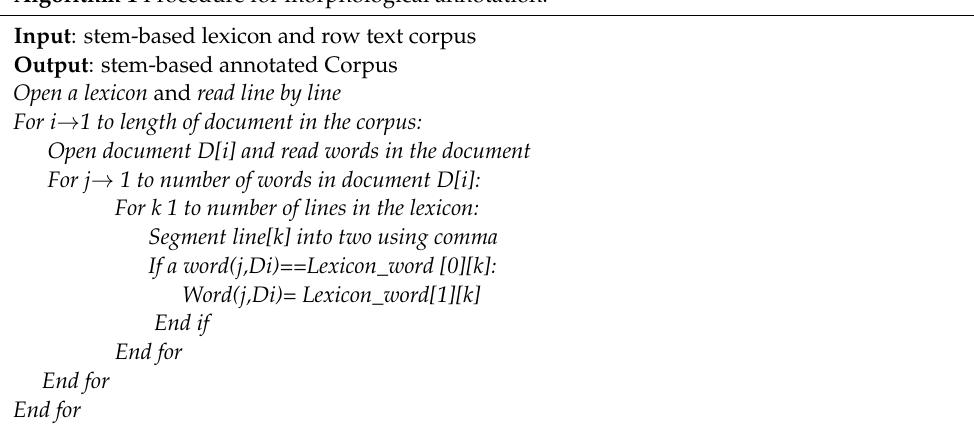
Algorithm 1 Procedure for morphological